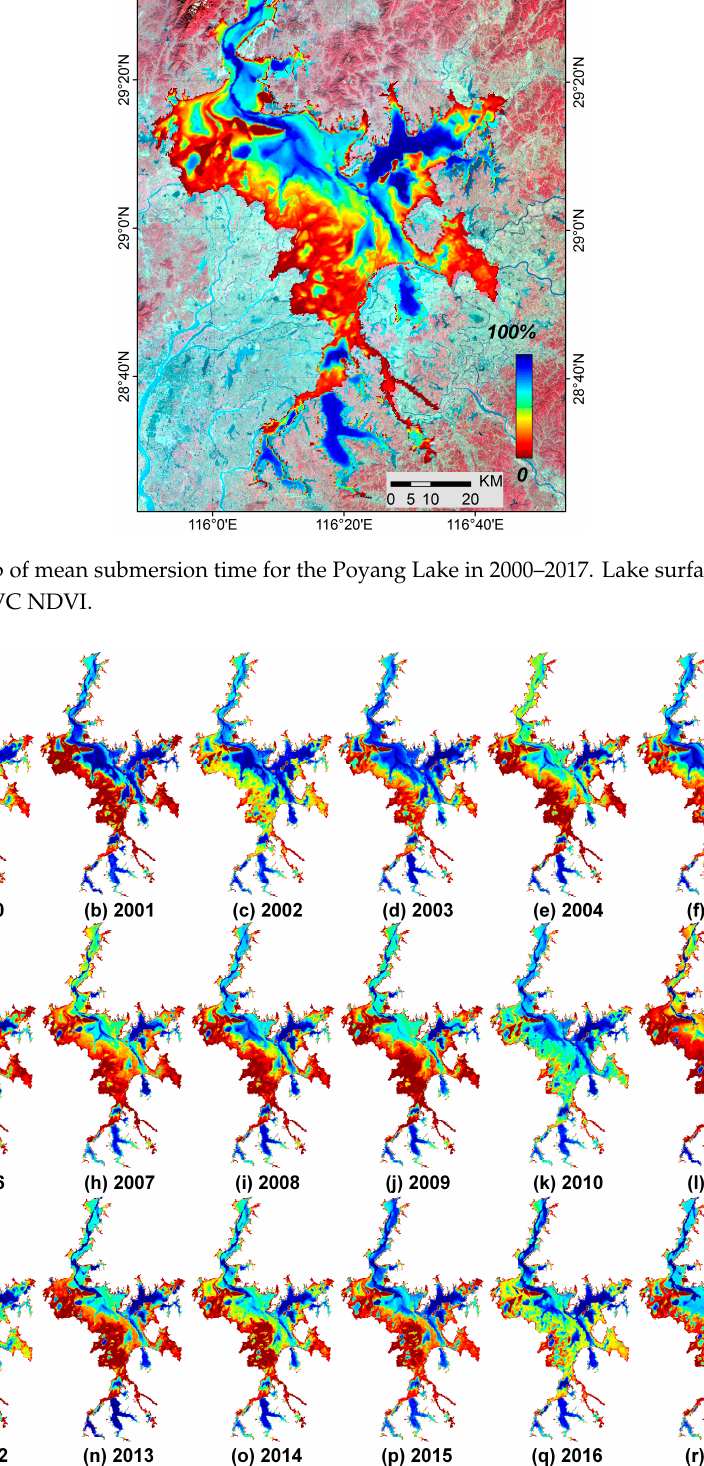
Figure 12. Annual maps of water submersion time for the Poyang Lake in 2000–2017 derived from the baseline MinVC NDVI based water surface area data.